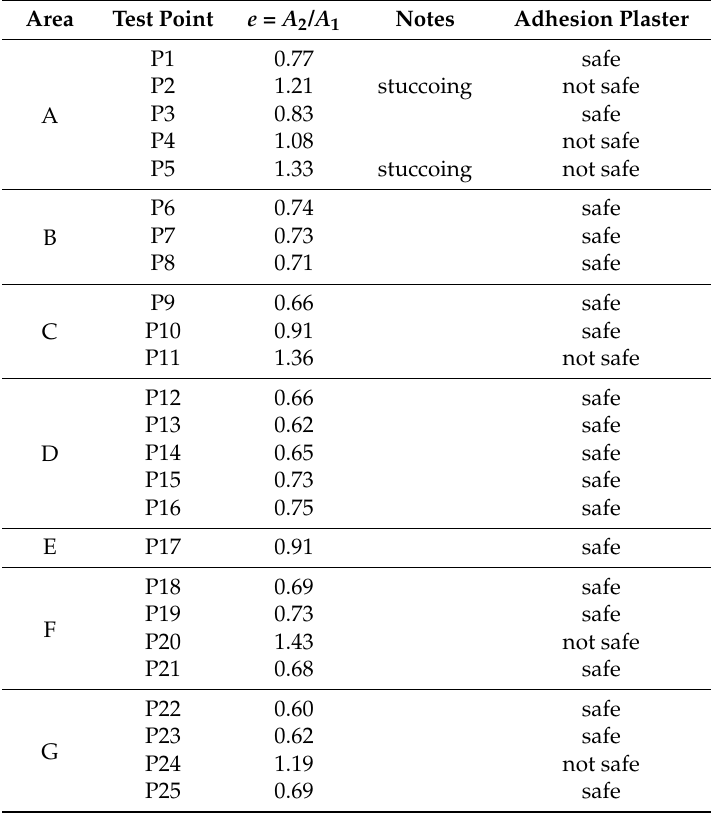
Figure 8. Map of the points and areas tested on the vault of the Pelagi room. Table 1. Results of impact test on Pelagi room vault.